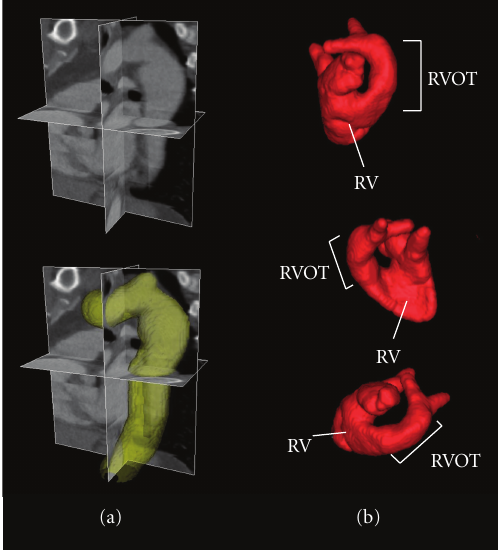
Figure 13: (a) 3D contrast-enhanced CT scan of the aorta (top left), and the same scan with an overlaid 3D segmentation (bottom left) achieved using the Shells and Spheres framework. (b) Surface rendering of a Shells and Spheres segmentation of the right heart with labeled Right Ventricle (RV) and Right Ventricular Outflow Tract (RVOT), shown from three di ff erent perspectives.